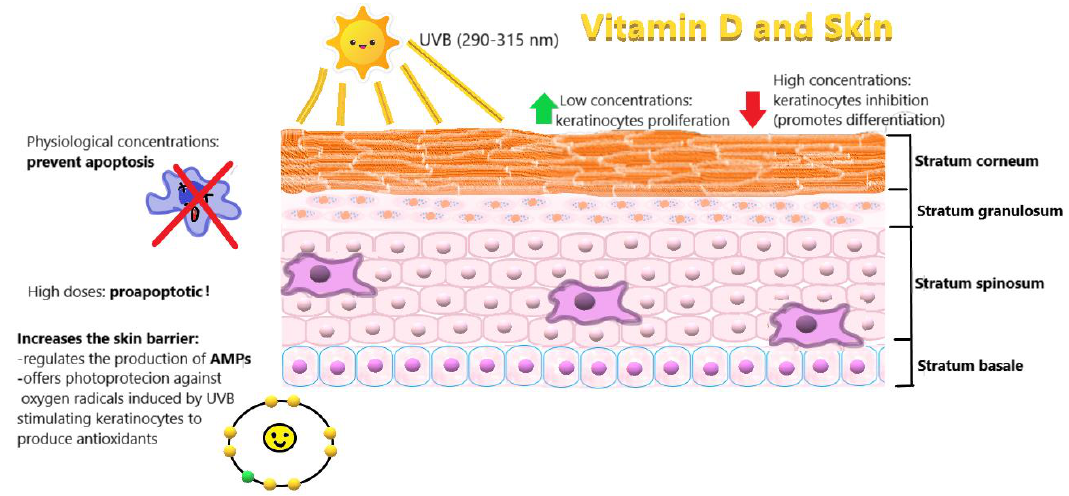
Figure 2. Physiological effects of vitamin D (VD) on the skin. Modulation of keratinocyte production, prevention or promotion of apoptosis (dose dependent), and promotion of the production of structural proteins of the stratum corneum by increasing the skin